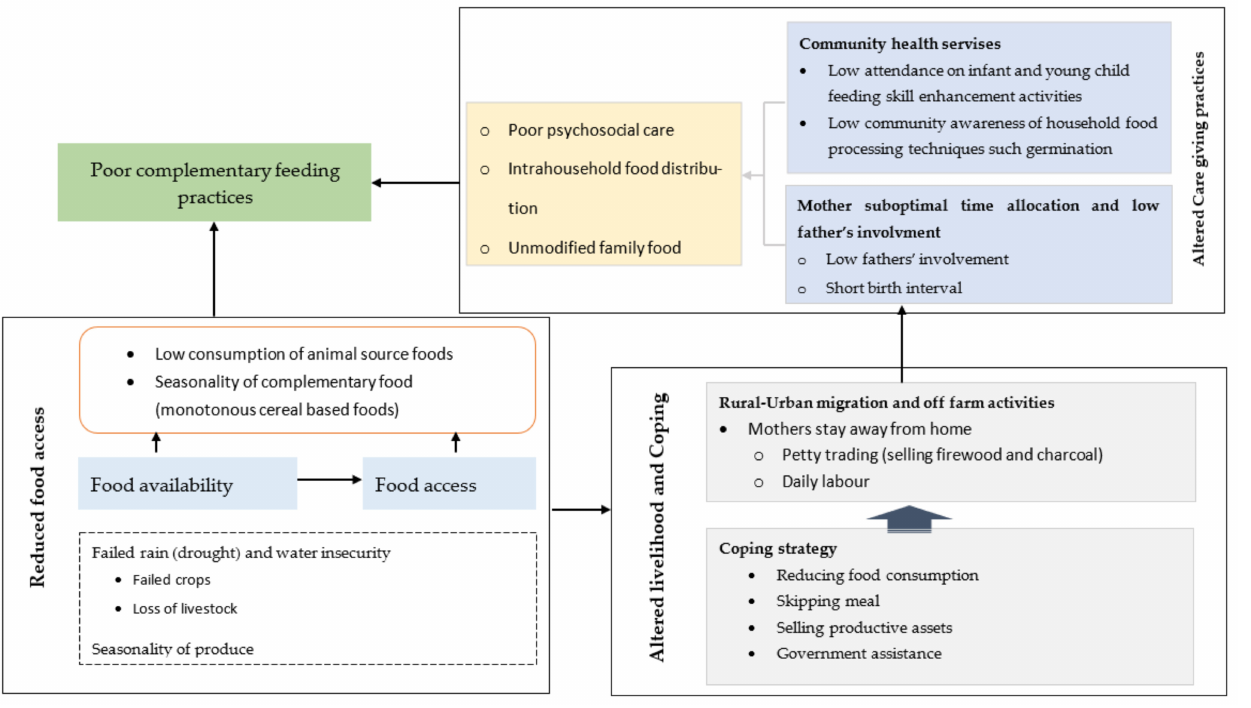
Figure 2. Factors that affect complementary feeding practices in El Niño affected community of Gale Mirga kebele of Kersa district